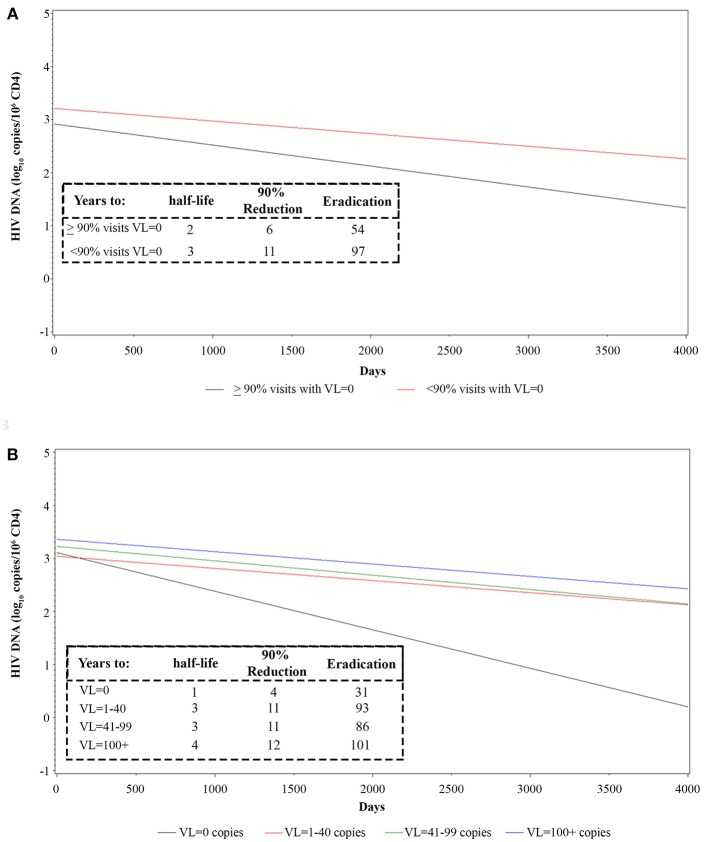
Longitudinal regression analysis and estimates of proviral HIV DNA decay in vaccinees stratified by frequency of intermittent viremia (A) or viremic classes (B). Effect of transient viremic events on proviral DNA decay (log10 copies/106 CD4+ T-cells) in vaccinees stratified by the percentage of visits with detectable VL measurements (VL = 0 copies/mL in ≥90 or <90% visits) (A) is shown. Effect of transient viremic events on proviral DNA decay in vaccinees stratified by VL intensity classes: persistent aviremic individuals (0 HIV RNA copies/mL) vs. subjects with 1–40 HIV RNA copies/mL, 41–99 HIV RNA copies/mL or ≥100 HIV RNA copies/mL (B) are shown. Insets: DNA decay kinetics parameter estimates for VL frequency (A) or intensity classes (B) are shown.